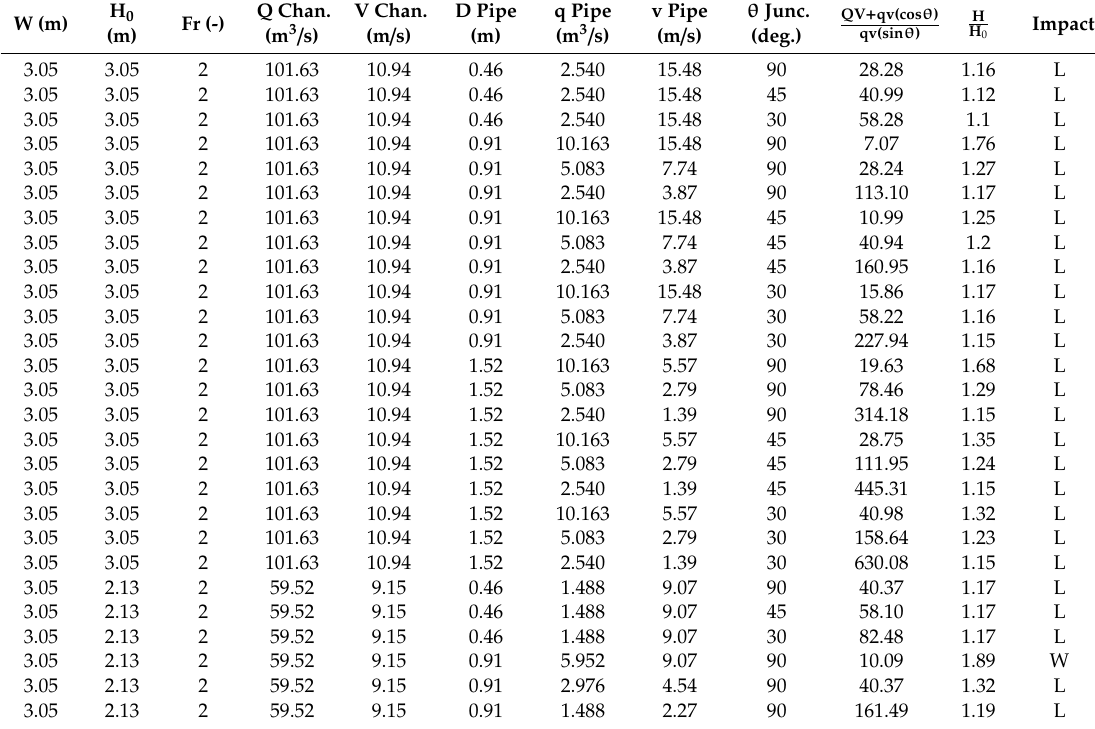
Table A1. FLOW-3D simulation results for W = 3.05 m (10’) and Fr = 2.